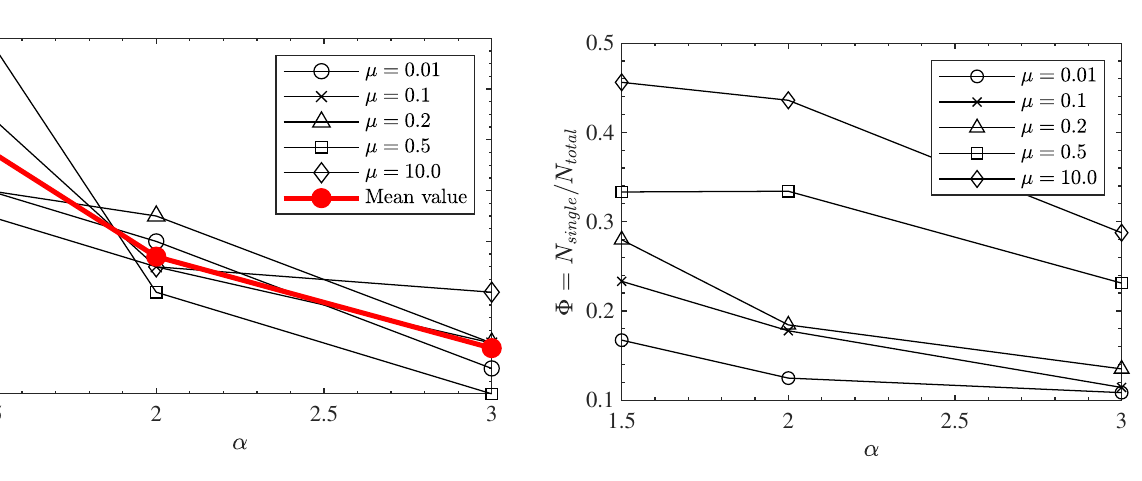
Figure 4. The value of ∆ θ c , where ρ f , Y peaks, vs. the aspect ratio α for di ff erent intergranular friction µ . The red line shows the mean value of ∆ θ c for each α .